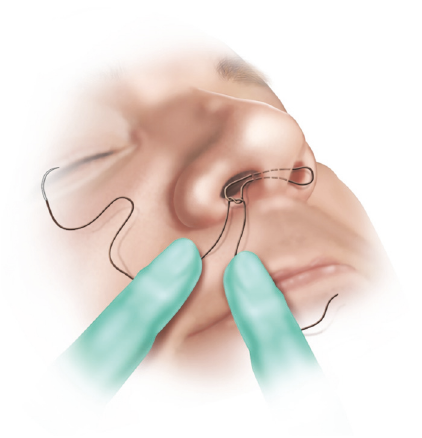
Figure 1: Step 1. A 4-0 Monocrylon a 19 mm precision point reverse cutting PS-2 curved needle is hand-tied at the caudal end of the septum.